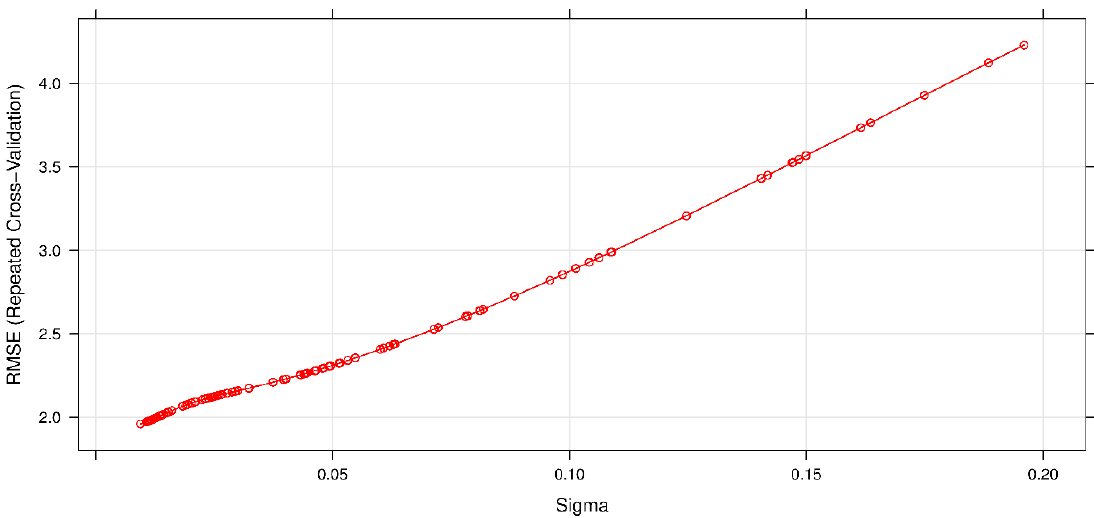
Figure 9. The development process of the Gaussian process (GP) model for estimating HL.